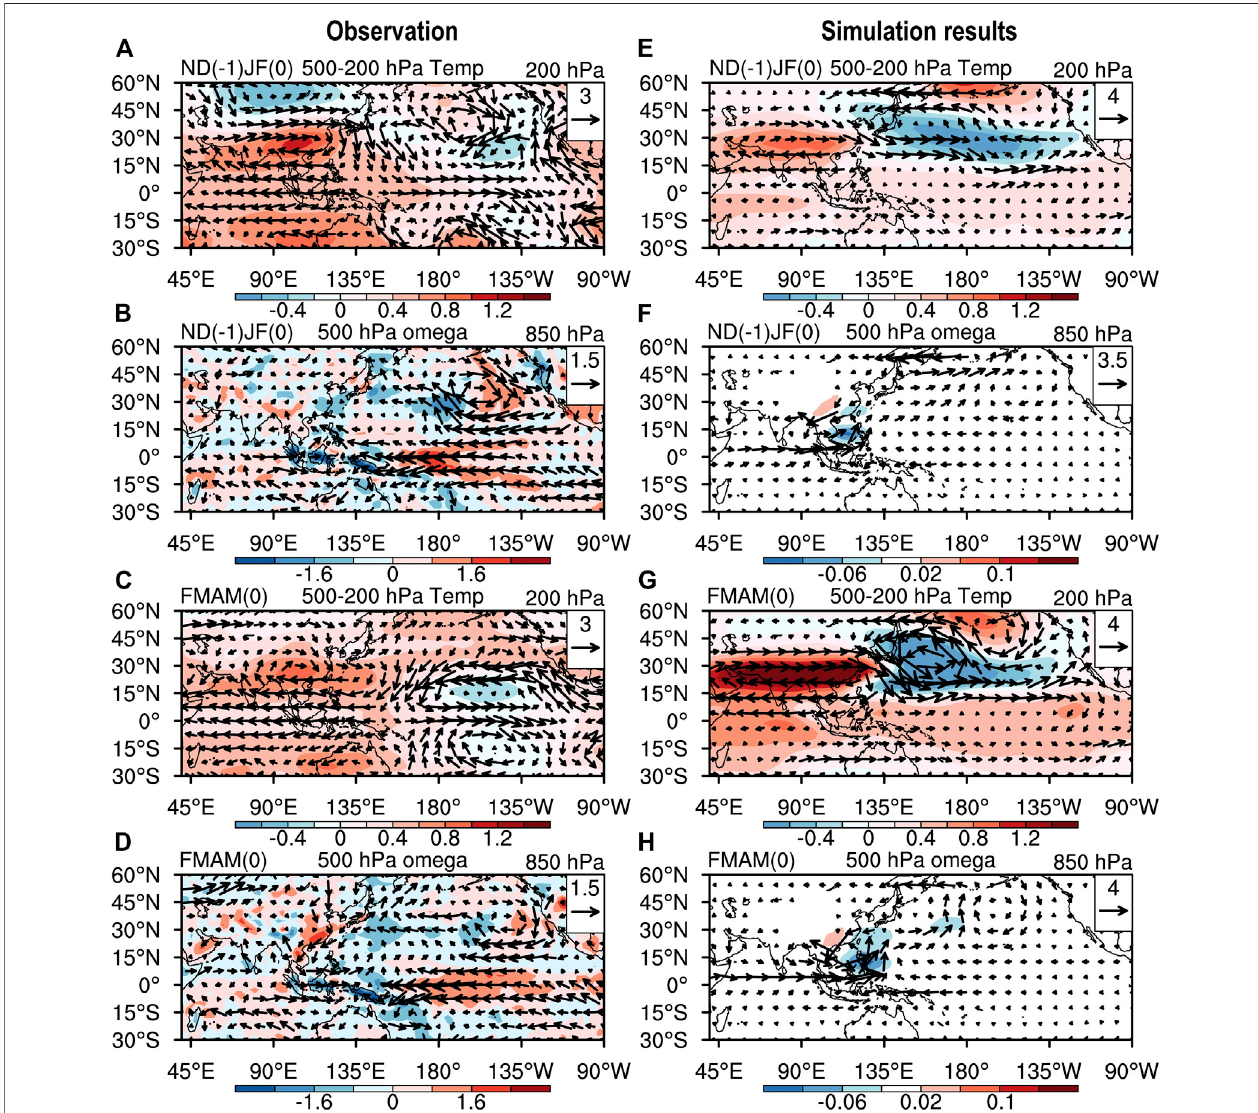
FIGURE 13 | Observation (left panel) and simulation (right panel) results ofheat source forcing: (A) , (E) 200 hPa wind (vector, m/s) and mid-upper tropospheric temperature(shading,K)forNovember-February; (B) , (F) 850 hPawind(vector,m/s)and500 hPa p -velocity(shading,10 – 2 Pa/s)forNovember-February. (C) , (G) same as (A) , (E) but for February – May. (D) , (H) same as (B) , (F) but for February –